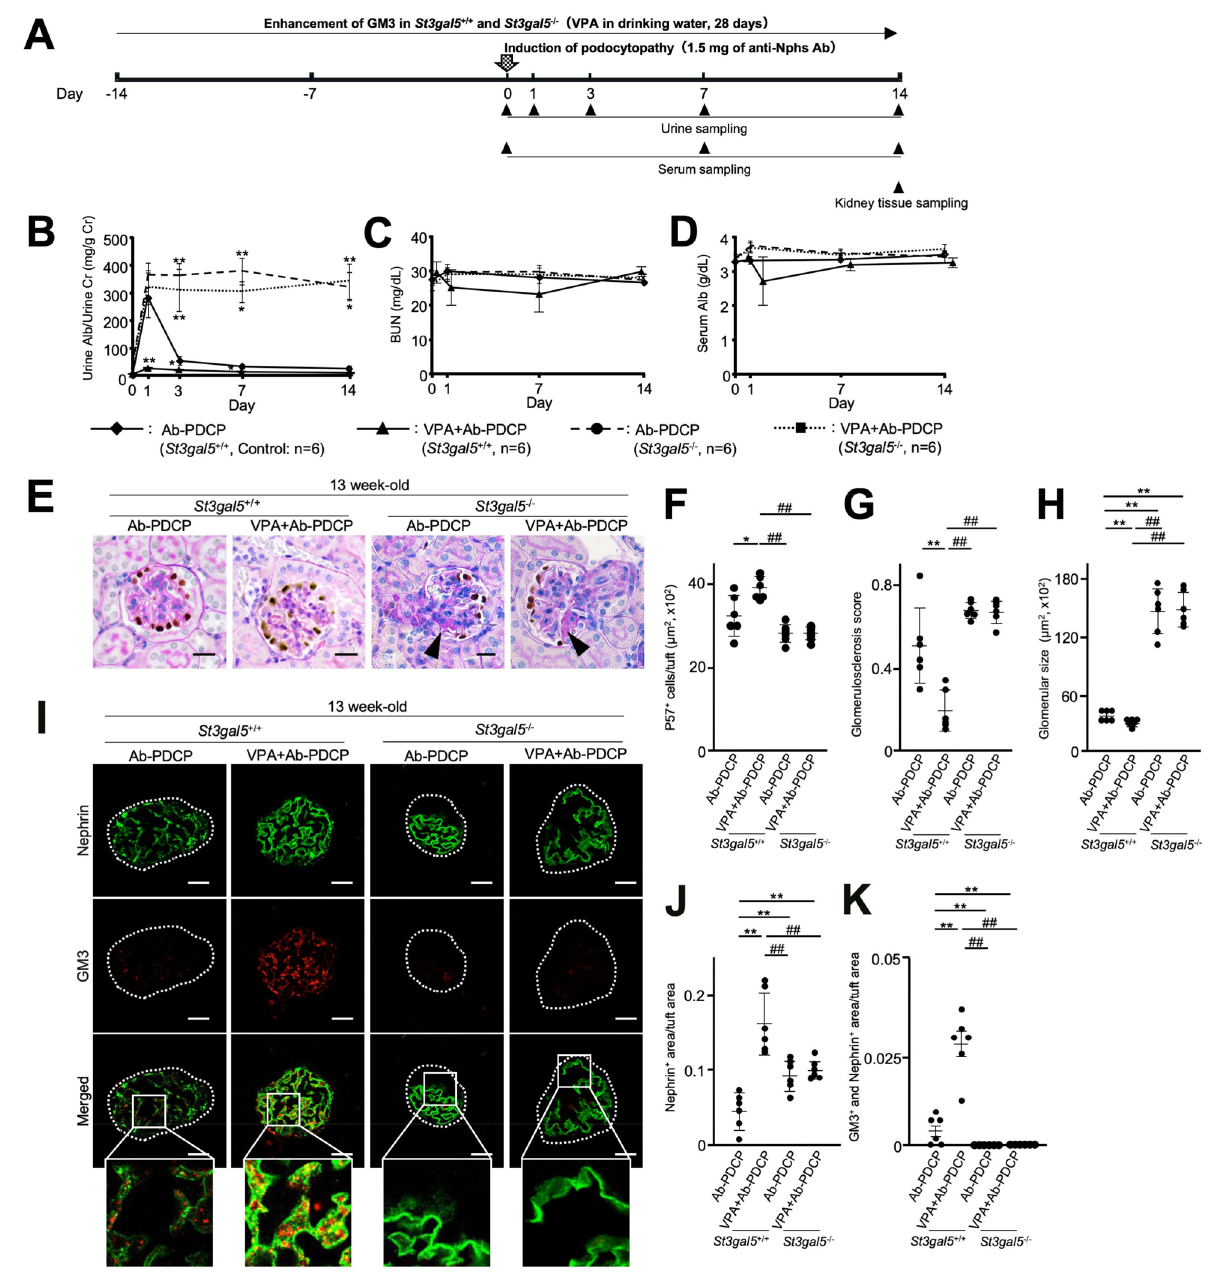
Figure 4. No preventive effect by administration of VPA in young GM3 synthase gene knockout ( St3gal5 −/− ) mice. ( A ) Schedule for podocytopathy prevention test using VPA. ( B ) Line graph showing urine albumin to creatinine, ( C ) urea nitrogen (BUN), ( D ) serum albumin (c). 1.5 mg of anti-nephrin antibody (anti- Nphs Ab)-induced podocytopathy (Ab-PDCP), and VPA + 1.5 mg of anti-Nphs Ab-induced podocytopathy (VPA + Ab-PDCP) in St3gal5 +/+ and St3gal5 −/− mice are shown as a solid line with diamond, a solid line with triangle, dashed line with circle and dotted line with square, respectively. * P < 0.05; ** P < 0.01 vs. St3gal5 +/+ . ( E ) p57 (podocyte marker, brown) and PAS staining of glomeruli. Arrowhead showing glomerulosclerosis. Scale bars: 20 µm. ( F ) Scatter diagram showing p57 + cells/tuft, ( G ) glomerulosclerosis score, and ( H ) glomerular size, respectively. Twenty glomeruli per mouse were analyzed in each dot. * P < 0.05; ** P < 0.01 vs. Ab-PDCP in St3gal5 +/+ , ## P < 0.01 vs. VPA + Ab-PDCP in St3gal5 +/+ . ( I ) Immunofluorescence staining images of glomeruli. Scale bars: 20 µm. Nephrin (green) and GM3 (red) merged areas (yellow) highlighted in enlarged images. ( J ) Scatter diagram showing nephrin (green) fluorescence area/tuft area, ( K ) GM3 (red) and nephrin (green) merged fluorescence area/tuft area. ** P < 0.01 vs. Ab-PDCP in St3gal5 +/+ , ## P < 0.01 vs. VPA + Ab-PDCP in St3gal5 +/+ . Statistical analyses were performed from mice (n = 6) in each